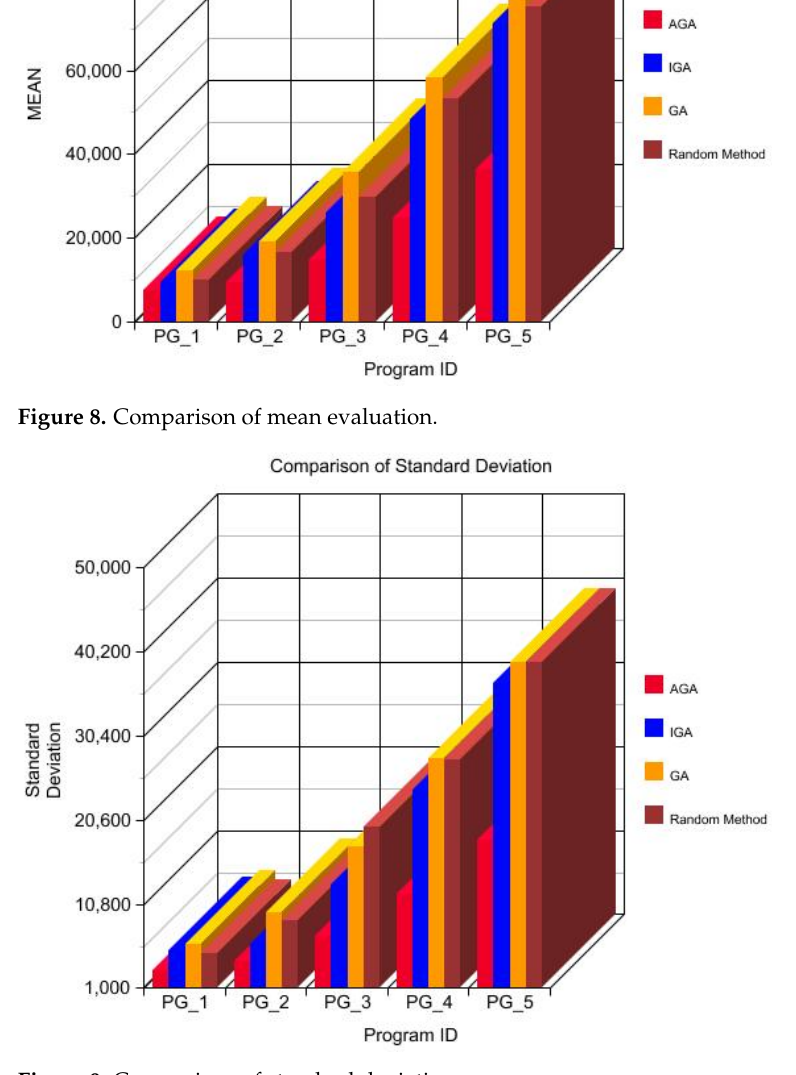
Figure 9. Comparison of standard deviation. Table 4. Parameter setting for the industrial trial programs. Table 5. Mean search time and success rate comparison of industrial